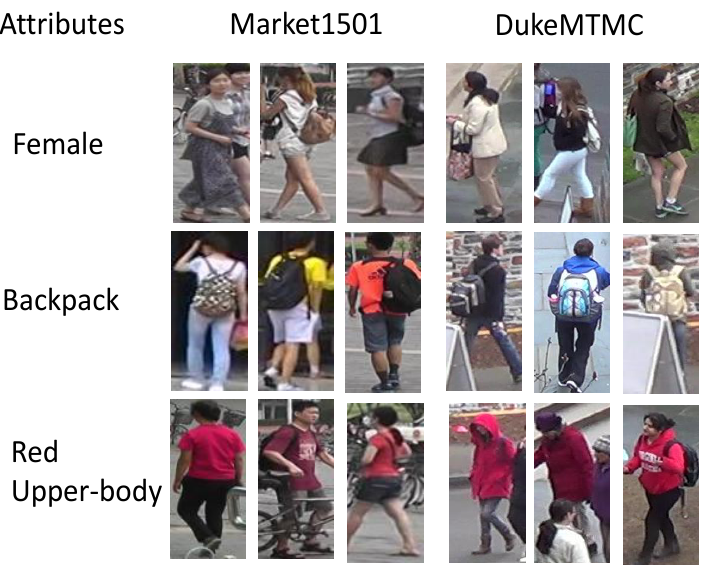
Figure 5. Generally shared attributes (e.g., upper-body color, backpack and gender) on DukeMTMC- reID and Market-1501